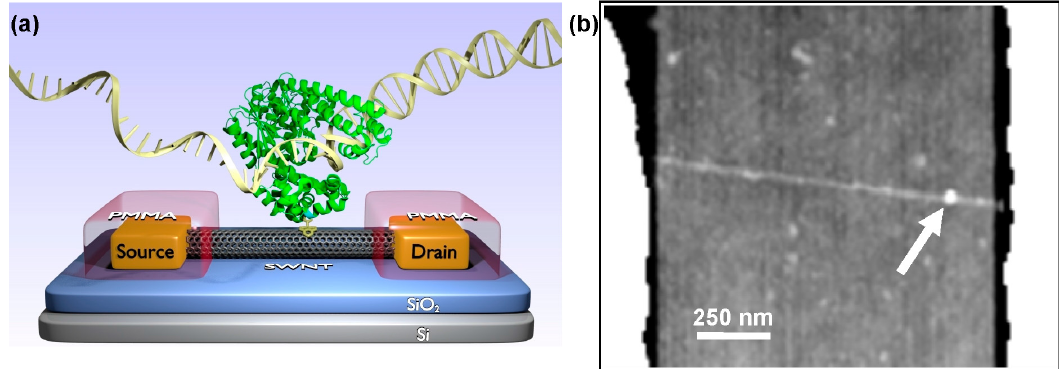
Figure 1. ( a ) Schematic of a single-walled carbon nanotube field effect transistor (SWNT-FET) functionalized with a single copy of a protein. This device depicts the Klenow Fragment of DNA polymerase I converting a single-stranded DNA template into a double-stranded helix. A pyrene-maleimide ( yellow ) is shown linking the protein to the SWNT. ( b ) Atomic force microscopy image of a typical SWNT-FET device after functionalization confirms attachment of a single protein ( arrow ).